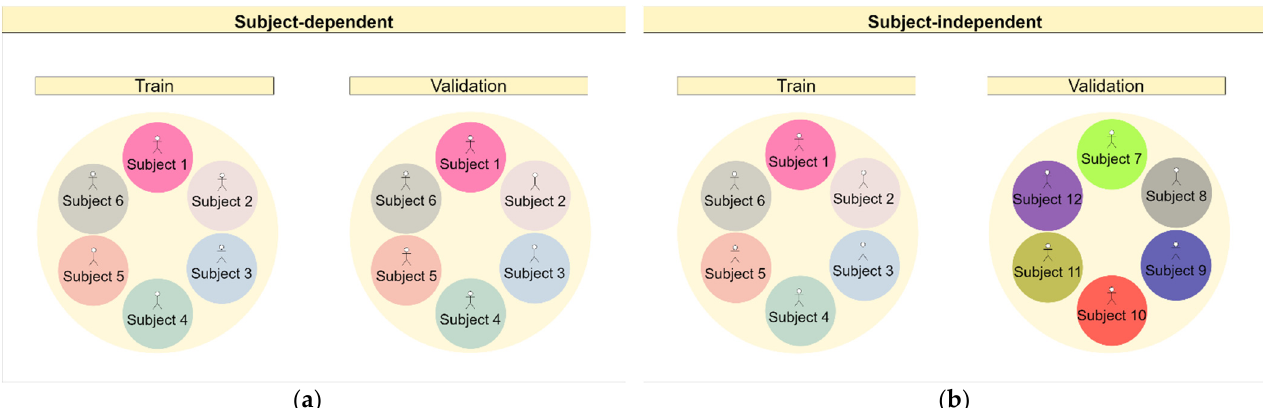
Figure 2. SD validation strategy and SI validation strategy. ( a ) We train and validate with the same subjects represented in the diagram by using circles with the same colors. In our case, we have 70% of the data for training and 30% for validation, which means that, on average, 70% of the total data from each individual were used in training, and the remaining in validation. ( b ) We have different subjects present in the training and validation, represented by the circles in different colors. In our case, we decided that 30% of the total subjects would be used for validation and the rest for training. For the biometric user identification, each physical activity was considered a subset.